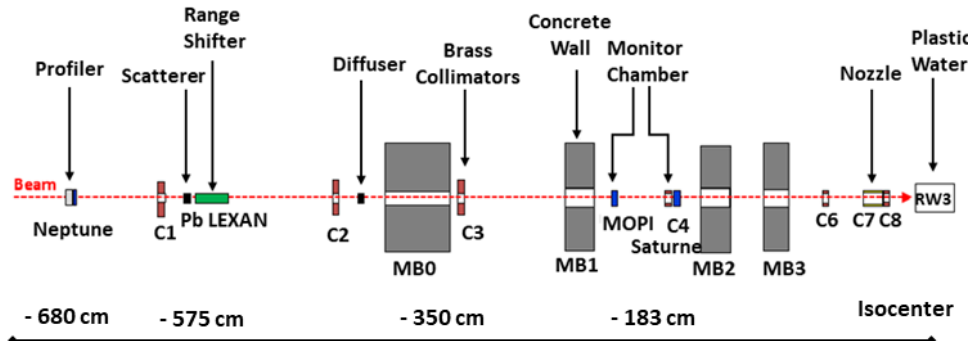
Figure 3. A schematic representation of the Y1 beam line of IC-CPO used in TOPAS/Geant4 simula-